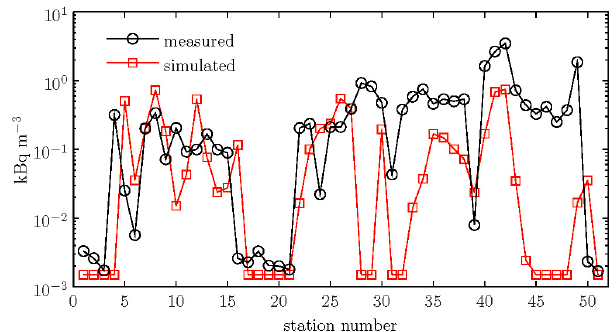
Fig. 8. Measured and simulated (using the observation-based model) estimates of 137 Cs surface concentration at the times and geographical locations corresponding to the KOK stations. Here, the detection limit for 137 Cs is 1.5Bqm − 3 (Buesseler et al., 2012), therefore to simplify the comparison, the simulated 137 Cs concen- trations have been cut off at the same